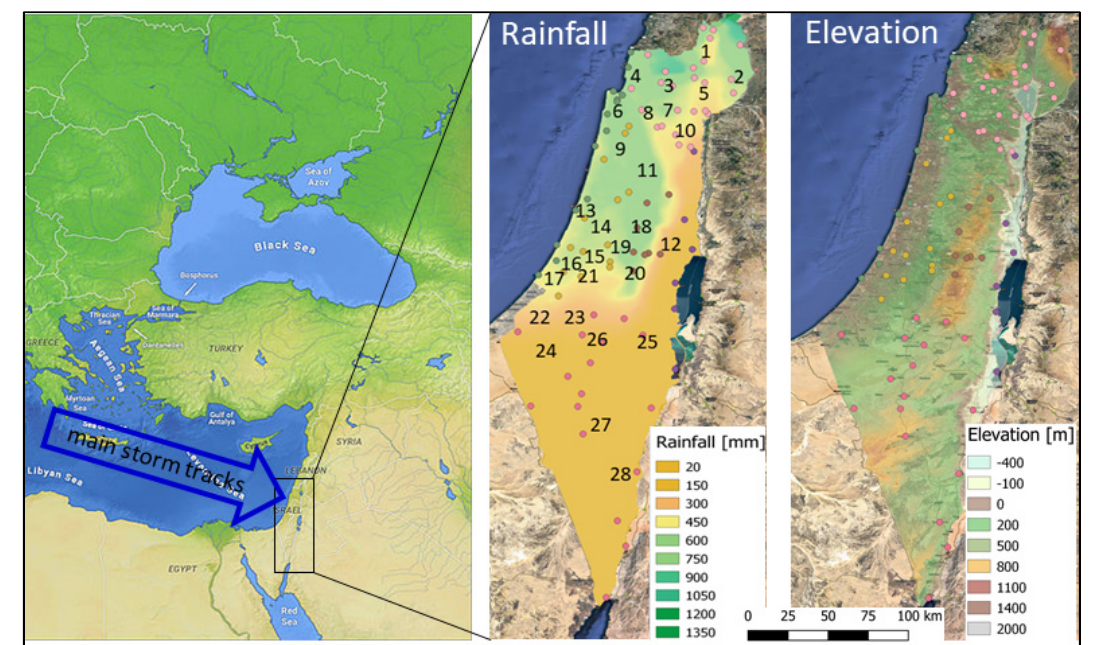
Figure 3. The study area: Israel. Left panel: its locations in the SE Mediterranean; central panel: its rainfall climatology (based on data for 1991–2020 provided by the Israel Meteorological Service) and numbers of subregions referred to in Figures 4, 6, 7, 8; right panel: topography [16].